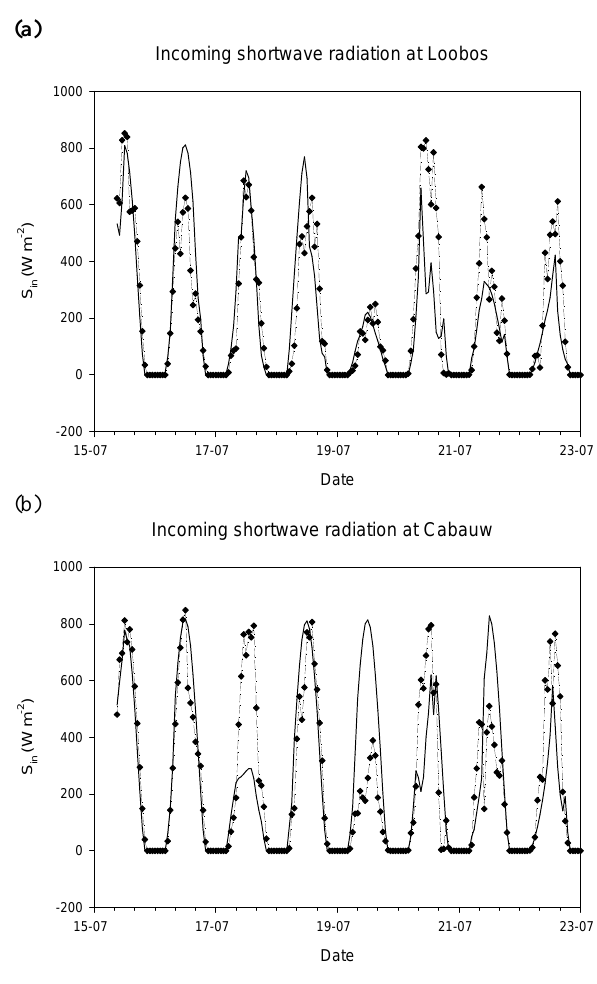
Fig. 7. Comparison of observed and simulated incoming shortwave radiation fluxes (Wm − 2 ) at the Loobos and Cabauw sites. Dia- monds and dotted lines: observed values. Black lines simulated at a grid point nearest to the Loobos site and representing the appro- priate tile. Tick marks are placed at 00:00h, same for Figs. 8, 9 and 14.